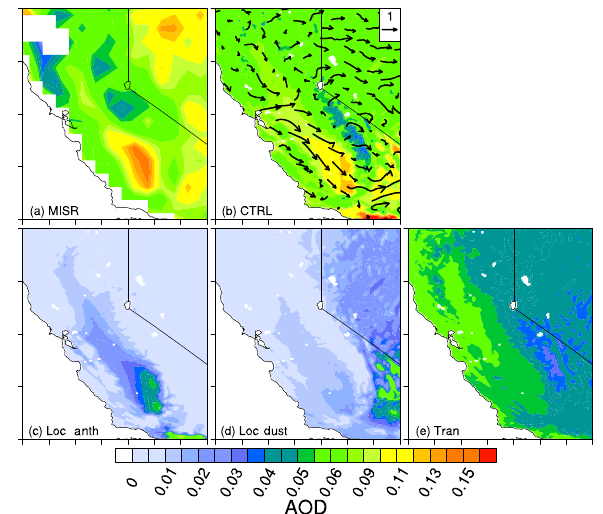
Figure 4. Spatial distribution of aerosol optical depth (AOD) aver- aged from October 2012 to June 2013 for (a) MISR observations, (b) all aerosols in the CTRL simulation, (c) local anthropogenic aerosols, (d) local dust aerosols, and (e) transported aerosols from outside the domain, derived from the difference between the CTRL simulation and the corresponding experiment (NoLocAnth, NoLoc- Dust, and NoTran); 10m wind vectors from the CTRL simulation are shown in (b)